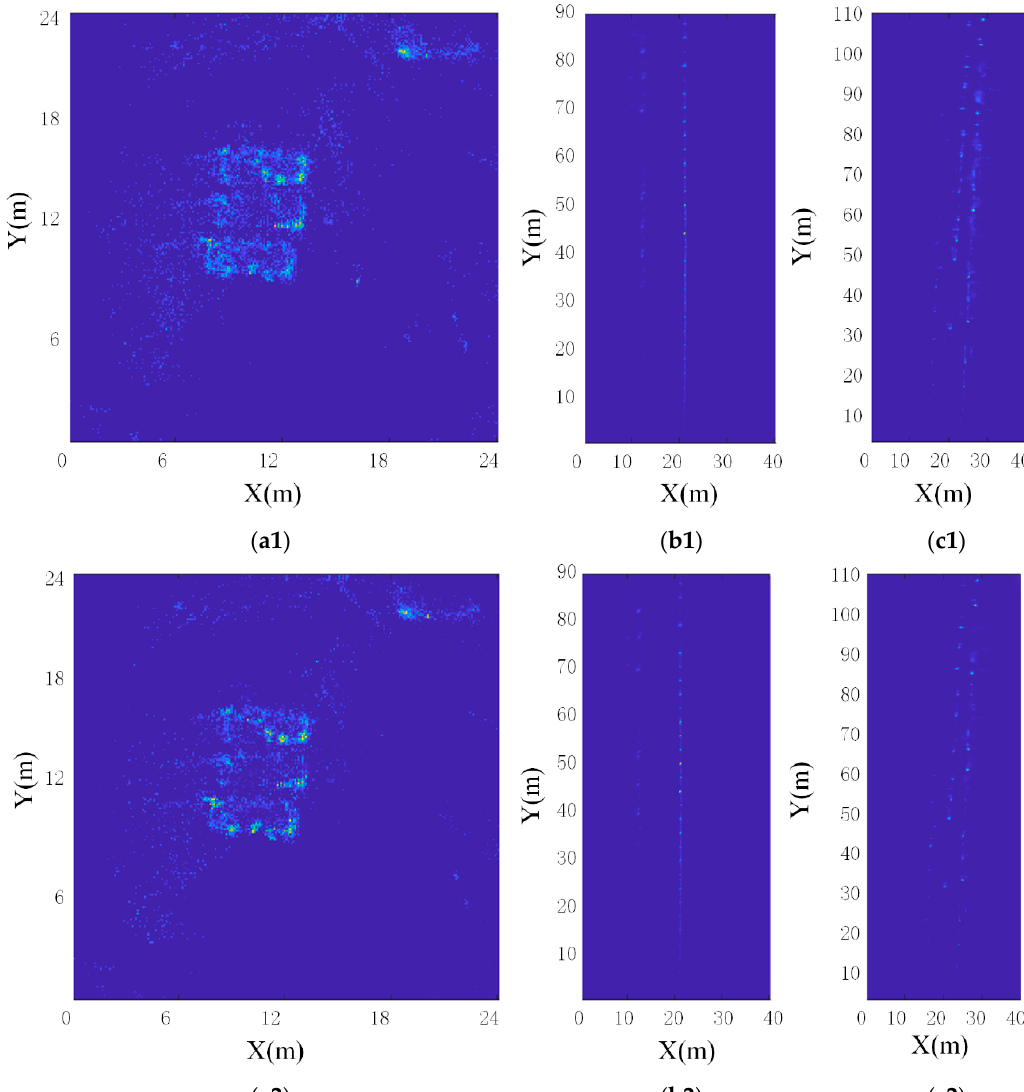
Figure 14. The three figures ( a – c ) correspond to the trajectories of the three scenes.